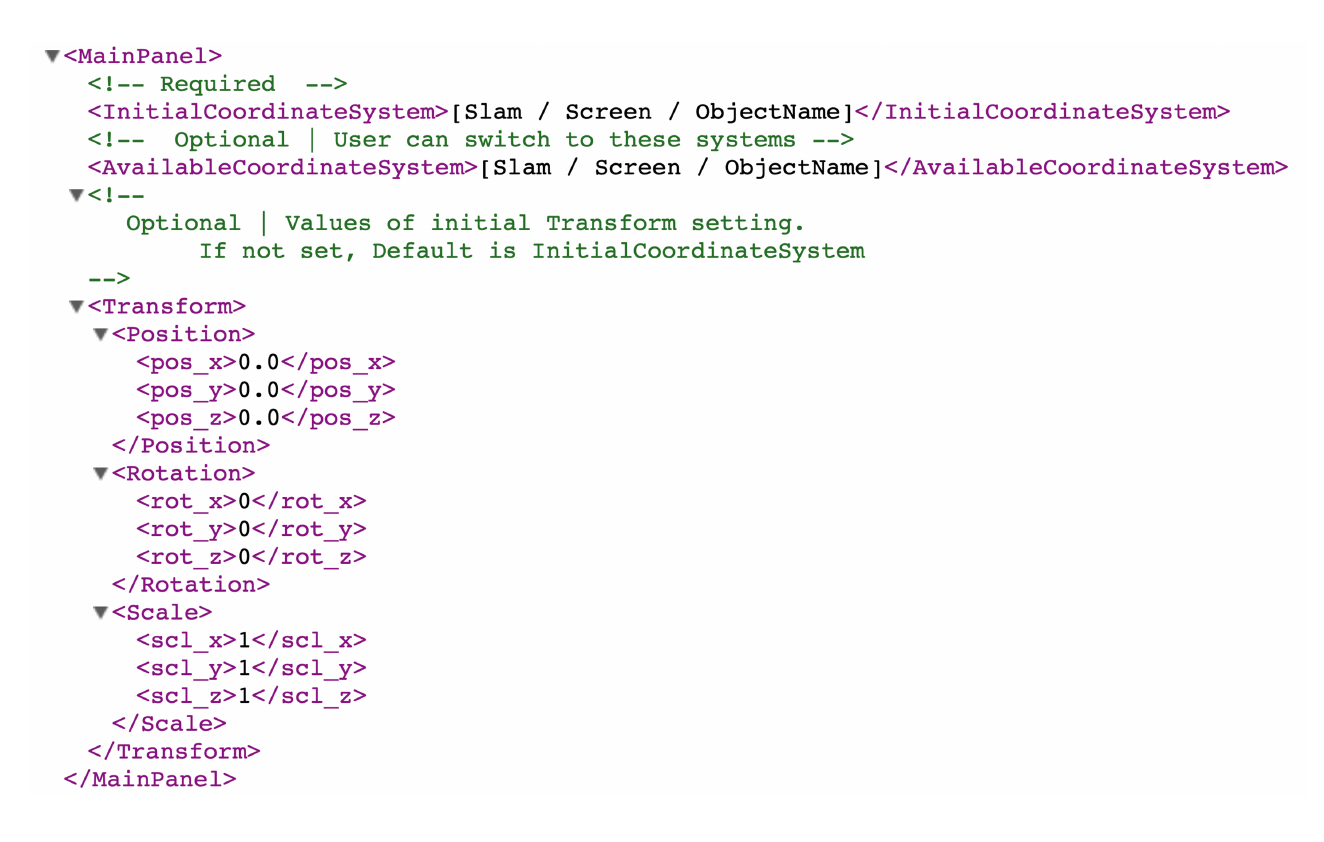
Figure 19. Example of Main-Panel element